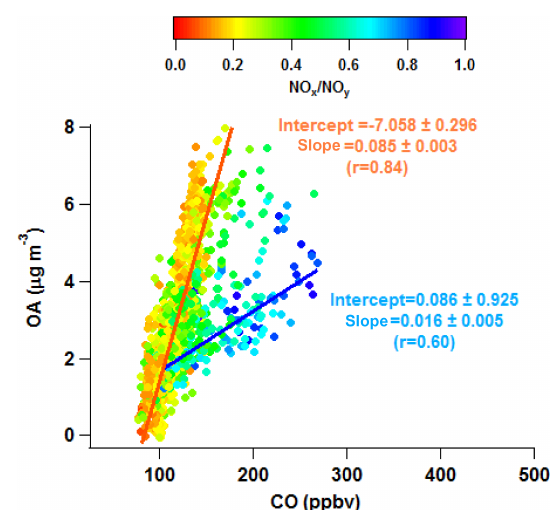
Figure 1. Scatter plot of OA against CO. The slopes are from weighted (by 30% uncertainty in OA and 3% uncertainty in CO) or- thogonal distance regression (ODR) fits to the data in relative fresh (NO x / NO y > 0.7) and aged (NO x / NO y < 0.3) plumes. The esti- mated uncertainties in the slope values represent 95% confidence intervals.